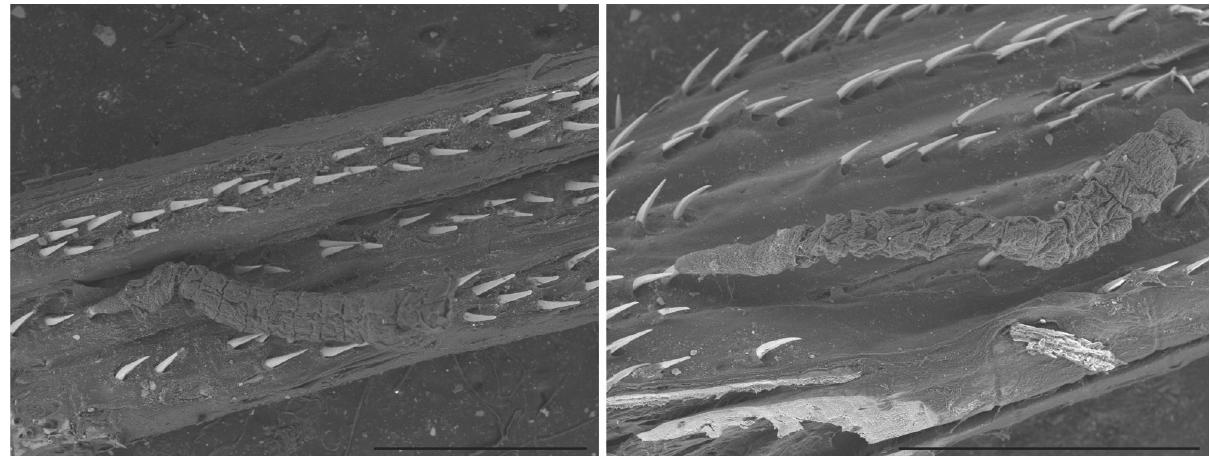
Figure 2. Larvae of Ichthyocladius sp. attached to a distal part of the abdomen (proleg) to a spicule on the pectoral fin of Ancistrus multispinis . Scale bars: 1 mm.